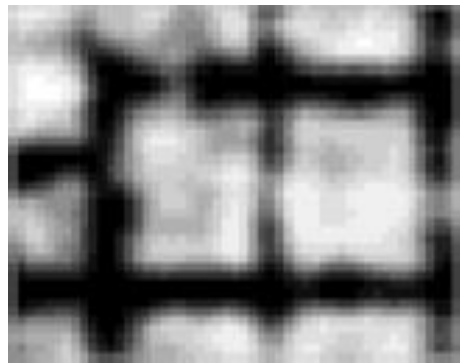
Figure 8. Radar image of reinforcing in concrete at 3.9 GHz. Mesh spacing is 20 cm × 20 cm at a depth of 3 cm to 4 cm [39].